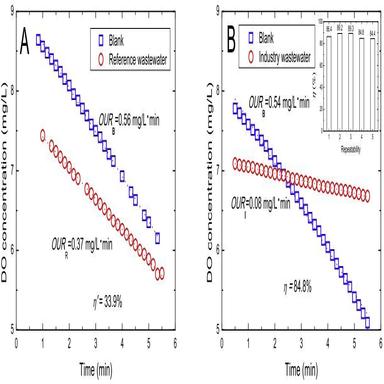
Oxygen uptake rate by nitrifying sludge in reference (A) and industry wastewater (B).